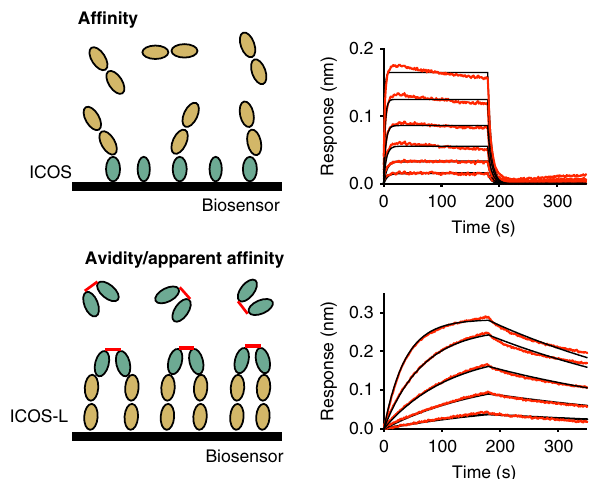
Fig. 4 Binding of recombinant ICOS and ICOS-L ectodomains. Schematic experimental set-up (left) and kinetic binding curves (right) for immobilized ICOS and ICOS-L as analyte (top) and inverted system (bottom) measured by